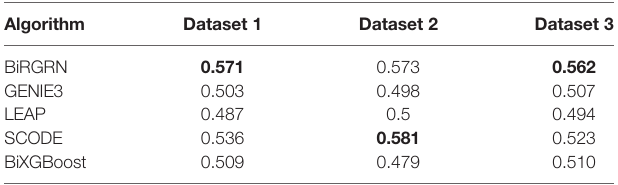
TABLE 2 | The AUROC value of the algorithm on three real scRNA-seq datasets. Algorithm